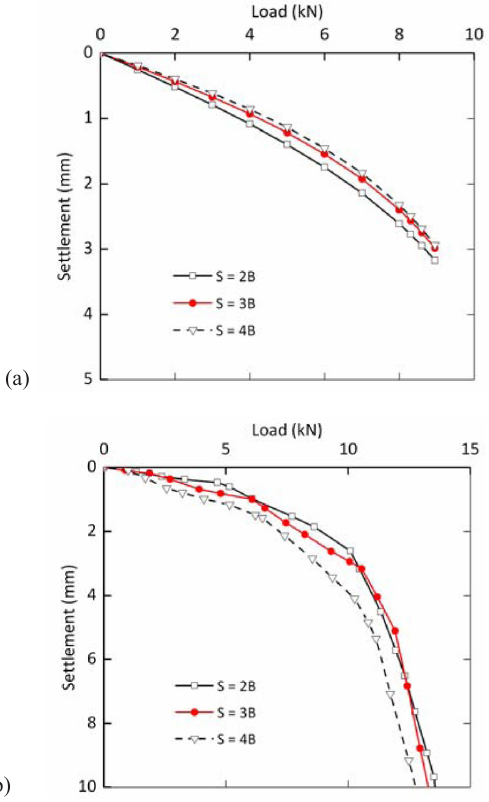
Fig. 20. Results for 4-pile group tests in medium sand with different center-to-center pile spacing: (a) Predicted load- settlement response for 4-pile groups; (b) measured load settlement response for 4-pile group